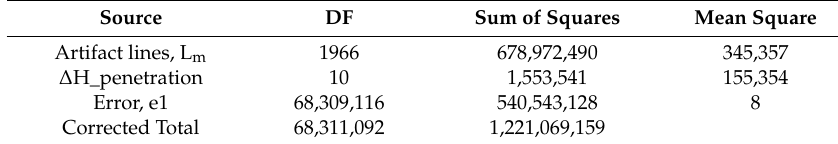
Table 1. Analyses of variance of the GLM model of ∆ H1 (m) (Equation (3)). The model had an R 2 of 56%. Source DF Sum of